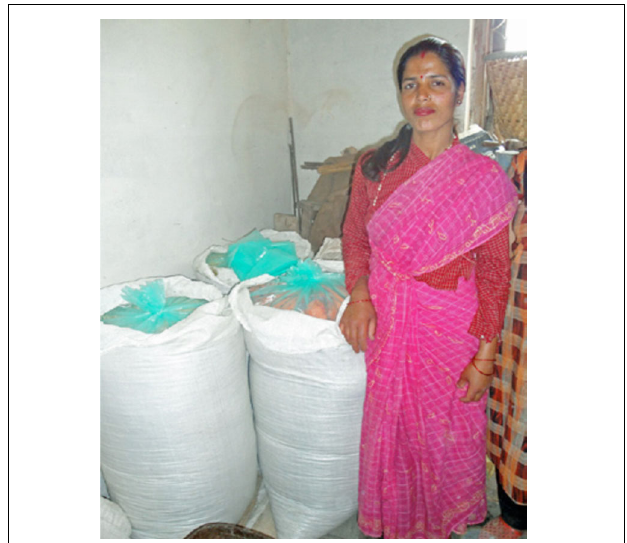
FIGURE 4 | Nepalese woman with SuperGrainbags, Mulpani Village near Kathmandu, Nepal.